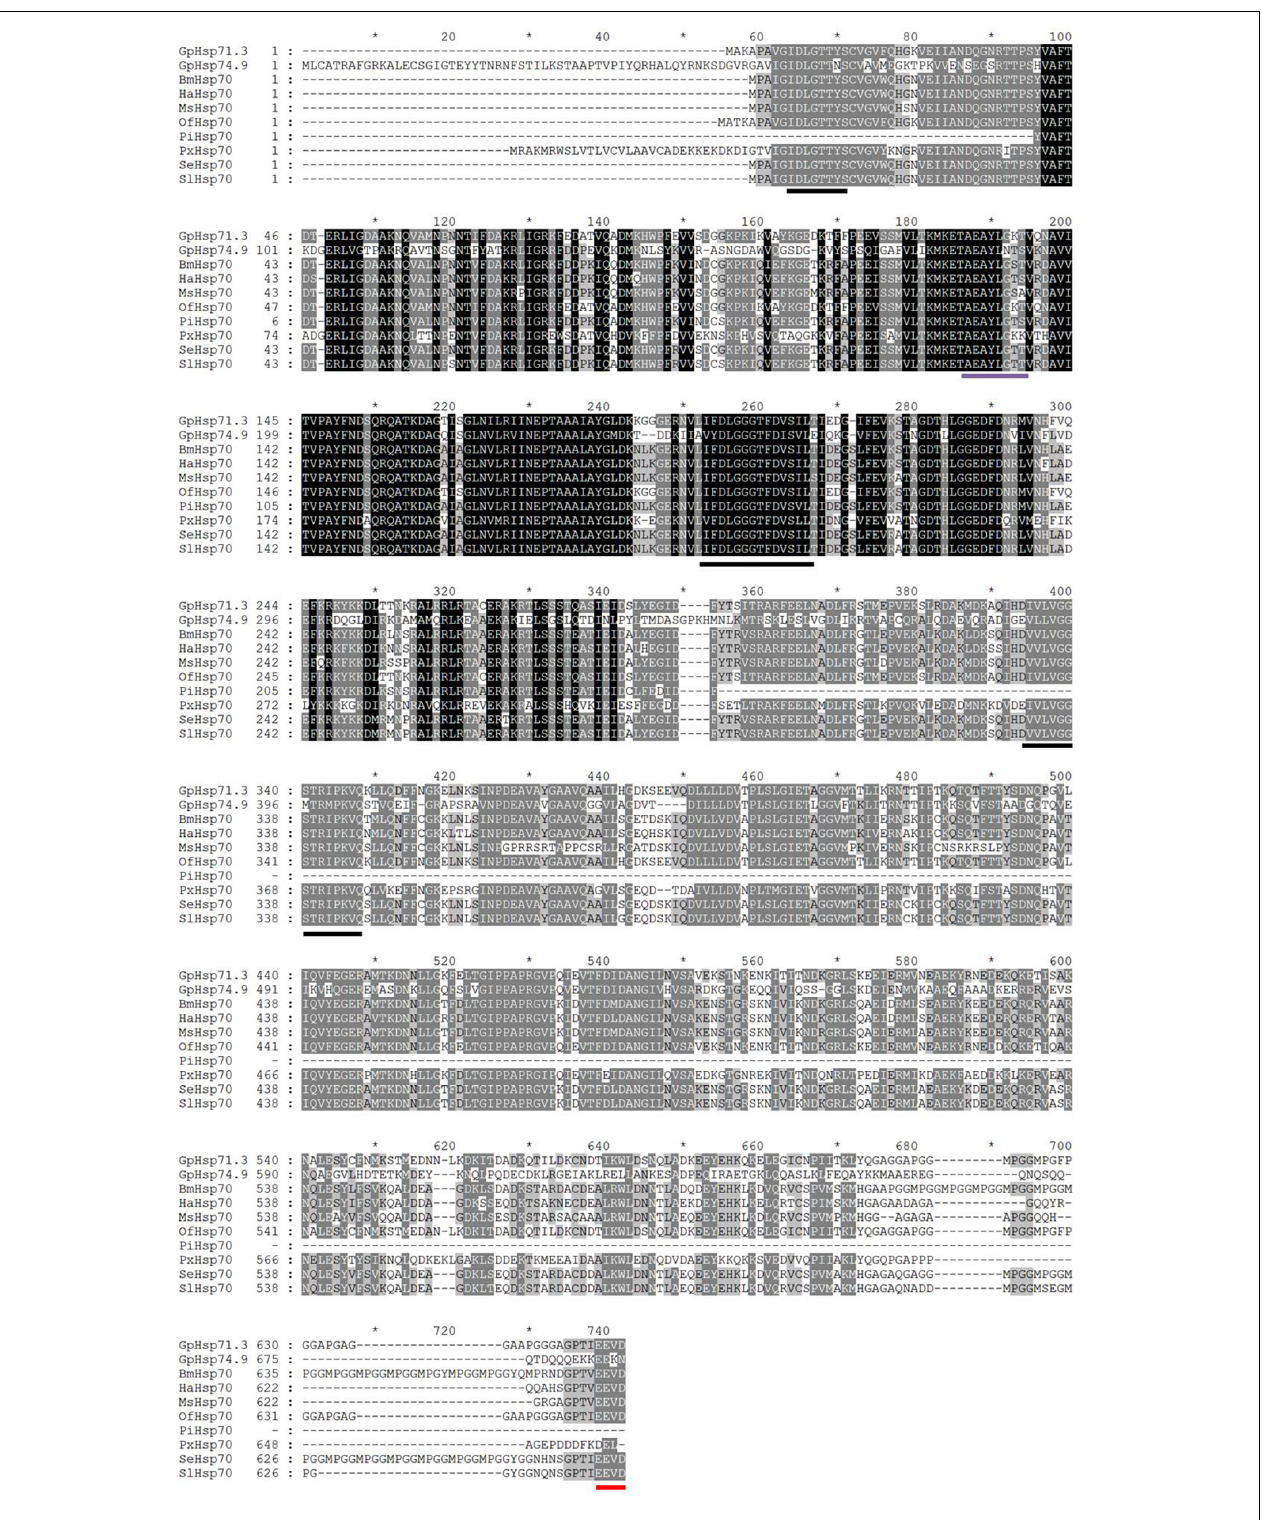
FIGURE 1 | Alignment of the deduced amino acid sequences of Hsp70 genes in G. pyloalis and other Lepidoptera insect. The conserved domains of Hsp70 gene family is underlined in Black solid line. Red solid line indicates a conserved amino acid sequence of EEVD motif at C-terminus and purple solid line indicates a ATP/GTP binding site motif. Bombyx mori (Bm), Helicoverpa armigera (Ha), Manduca sexta (Ms), Ostrinia furnacalis (Of), Plodia interpunctella (Pi), Plutella xylostella (Px), Spodoptera exigua (Se), Spodoptera litura (Sl).